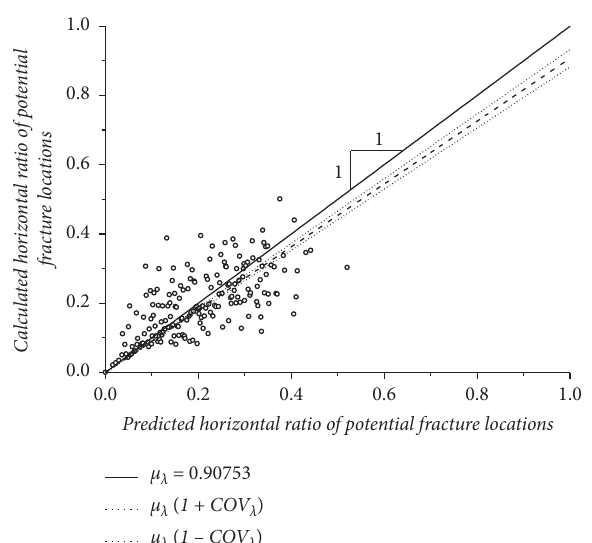
Figure 13: Plots of calculated versus predicted horizontal ratios of potential fracture locations.